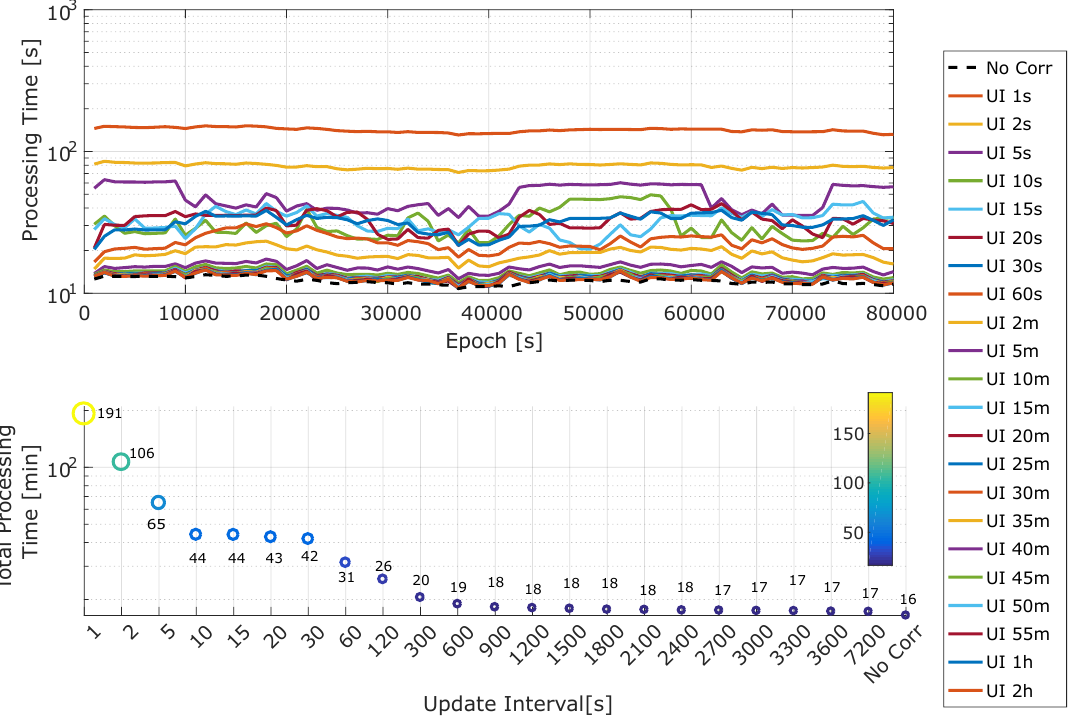
Figure 4. Upper: Median processing time required to process 1000 epochs as a function of time and of the update interval. Lower: Median total processing time as a function of the update interval. In the legend, “UI” stands for “Update